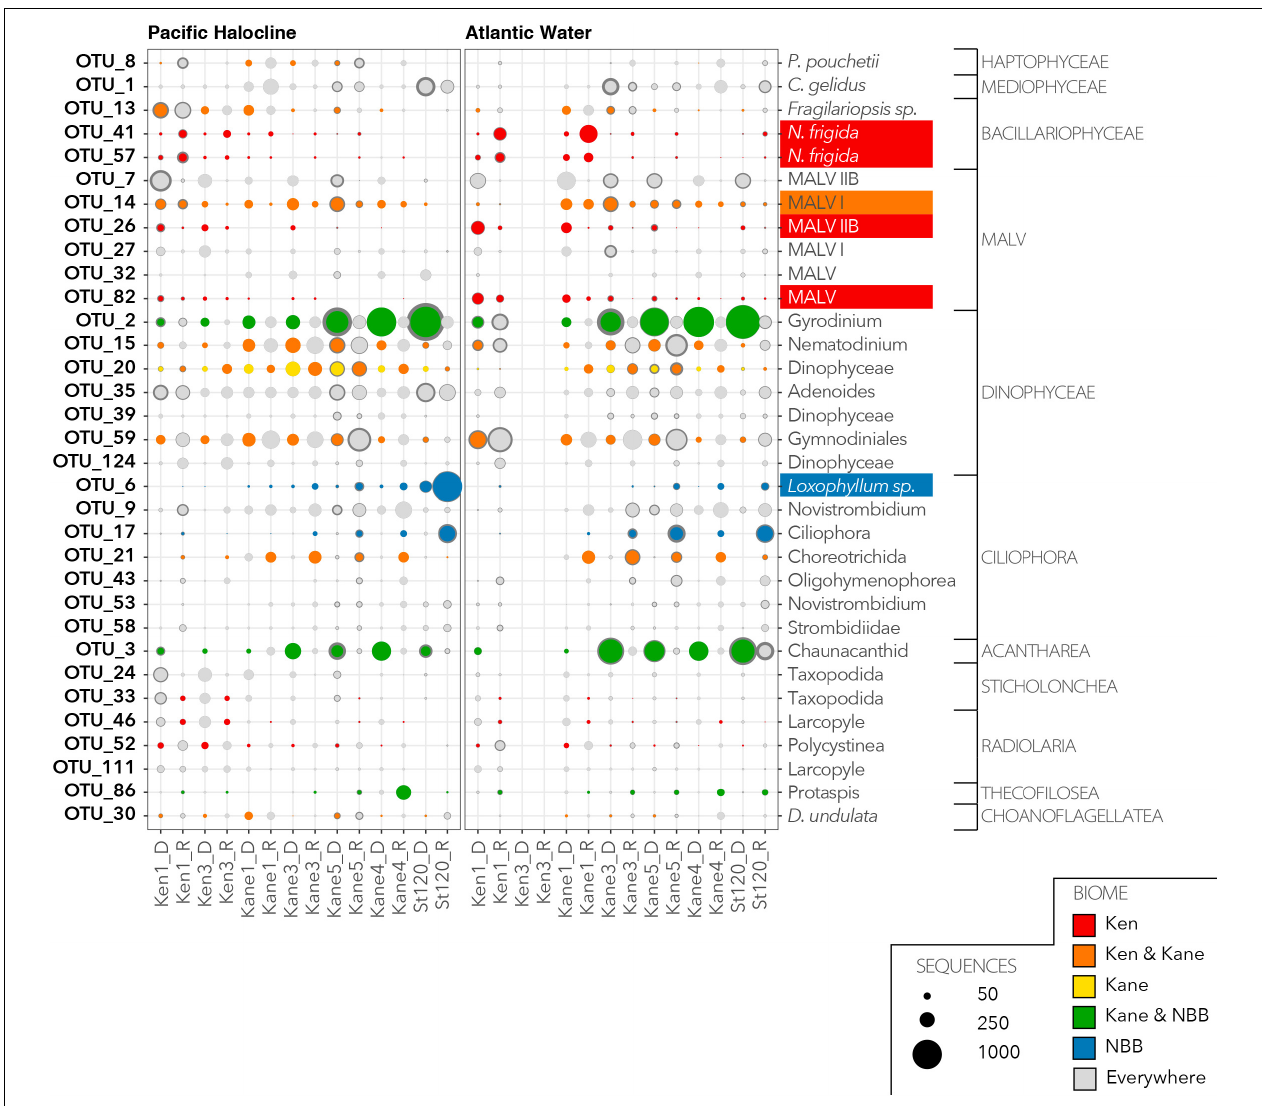
FIGURE 7 | Characteristic OTUs from the aphotic zone communities as for Figure 6 showing the deep water aphotic zone